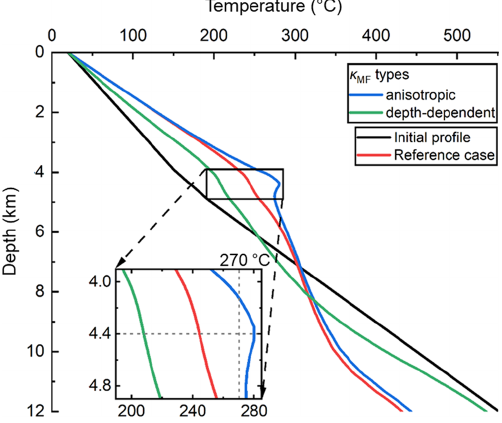
Figure 9. Effects of the sandstone permeability ( κ SST ) on the Pe (median Peclet numbers) of the main fault (MF), transfer faults (TF) and sandstone (SST).